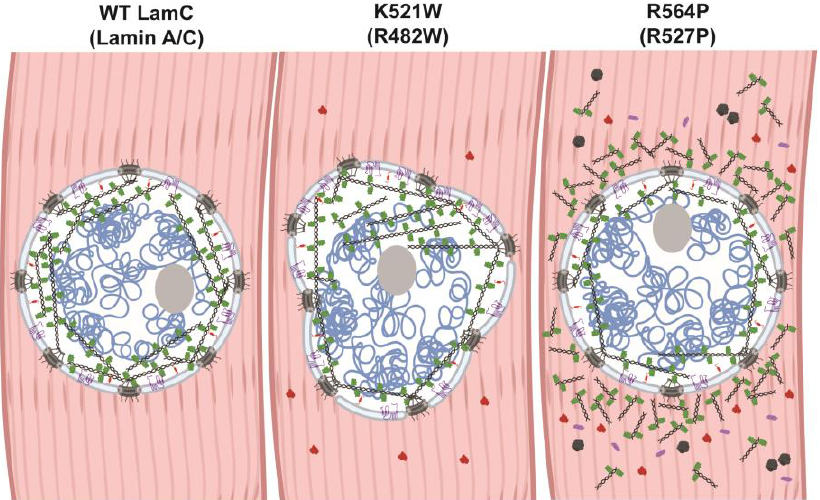
Figure 8. A model showing the differential effects of the two mutant lamins on the localization of nuclear proteins. ( Left ) Muscle expressing wild-type LamC (green) exhibit a lamin meshwork that lines the inner nuclear membrane. Nuclear pores (dark gray), TMEM43 (purple) and Otefin (red) are confined to the nuclear envelope. The DNA is represented in blue and the nucleolus organizer in gray. ( Middle ) Muscle expressing LamC K521W exhibits an uneven distribution of the lamin meshwork and nuclear lobulations with nuclear pores and TMEM43 confined to the nuclear envelope. By contrast, a portion of Otefin is mislocalized to the cytoplasm. As a result of the nuclear shape change, the genomic DNA (blue) has an atypical distribution. ( Right ) Muscles expressing LamC R564P exhibit abnormal localization of LamC, FG-repeat nuclear pore proteins, TMEM43, and Otefin throughout the cytoplasm.